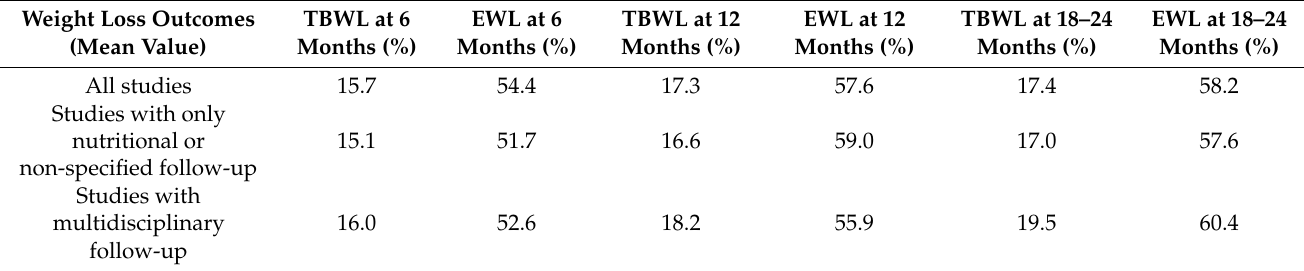
Mean TBWL and EWL after ESG with Apollo Overstitch among the studies according to ancillary post-procedure